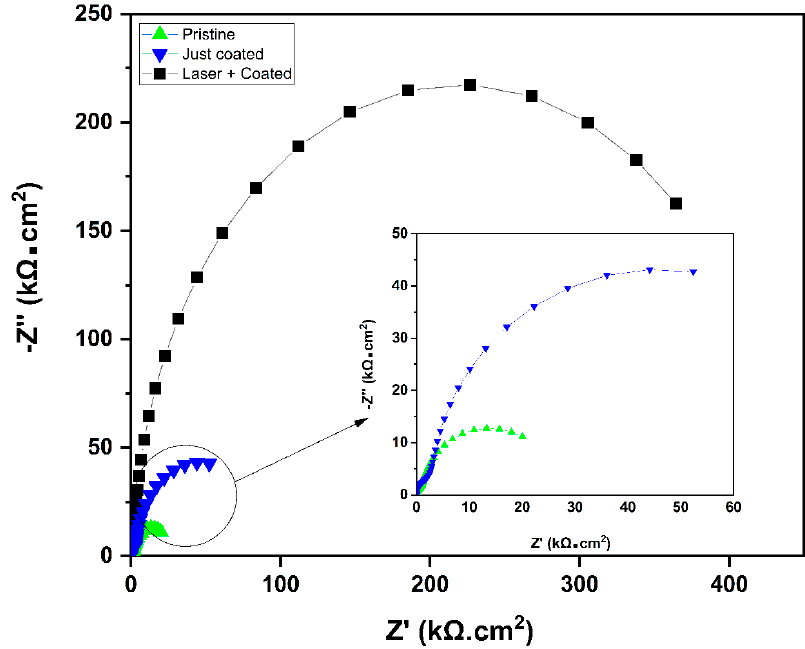
Figure 9. EIS analysis of pristine, just laser-structured, just-coated, and laser-structured with Mo- coated samples. The Nyquist plot of the laser-treated and coated samples have the largest diameter (i.e., greatest resistance) compared to the just-coated as well as pristine samples.